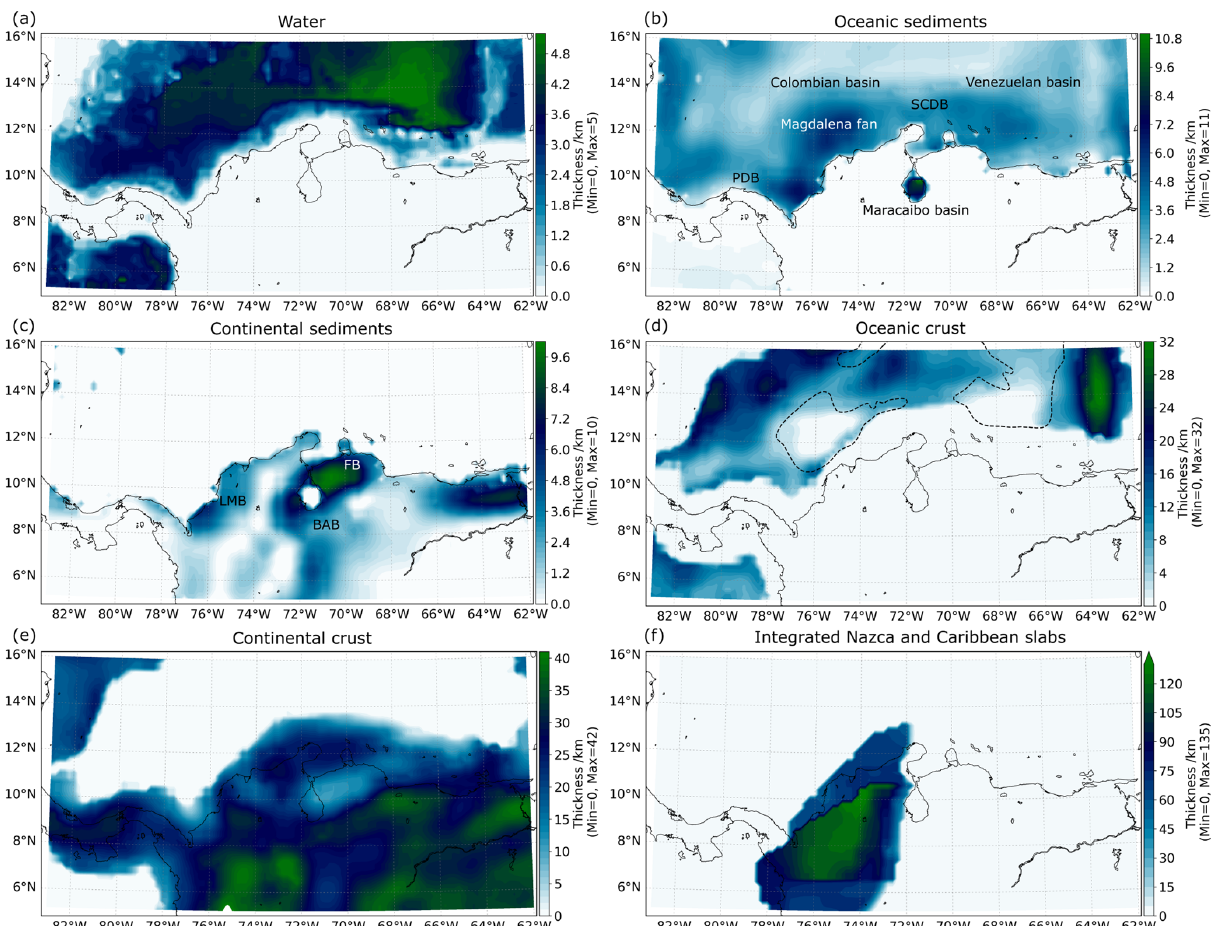
Figure 3. Structural layers used in the starting model: (a) water thickness from GEBCO (Weatherall et al., 2015), (b, c) unconsolidated oceanic and continental sediments based on CRUST1.0 (Laske et al., 2013), (d, e) oceanic and continental crystalline crust thicknesses (the dashed lines in d represent places where the oceanic crust is thinner than 10km; Mauffret and Leroy, 1997); (f) integrated slab thickness from the Nazca (Hayes et al., 2018) and Caribbean (Mora et al., 2017) subductions. The independent thickness maps of the slabs are presented in Fig. S2. BAB is the Barinas-Apure basin. FB is the Falcón Basin. LMB is the Lower Magdalena Basin. PDB is the Panamá Deformed Belt. SCDB is the South Caribbean Deformed